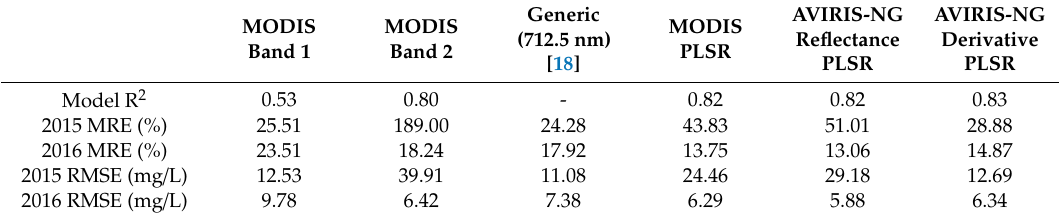
Table 2. Total suspended solids (TSS) model performances in the Louisiana study site (training n = 35)